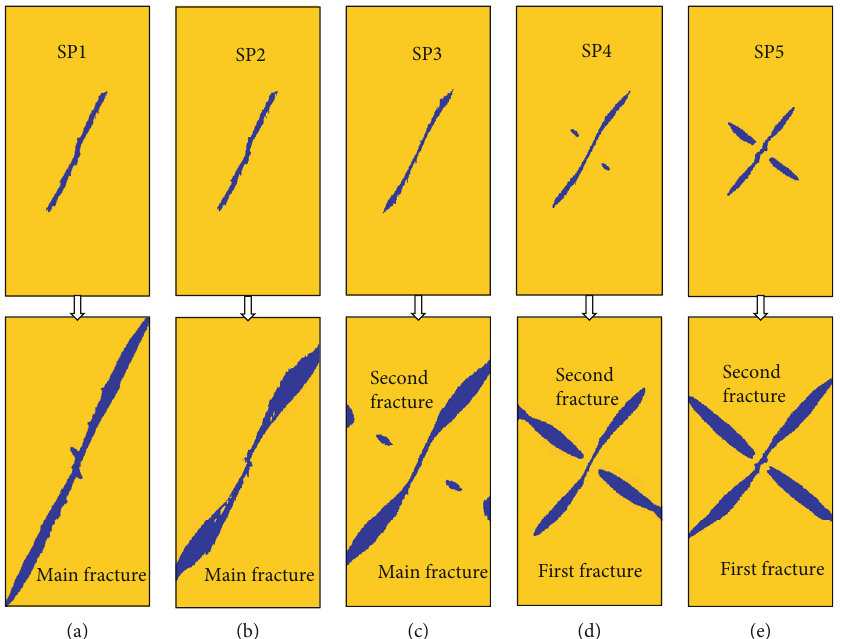
Figure 6: Crack propagation patterns a ff ected by the di ff erent schemes of the strength parameters: (a) pure tensile; (b) main tensile; (c) tensile-shear; (d) main shear; (e) pure shear.